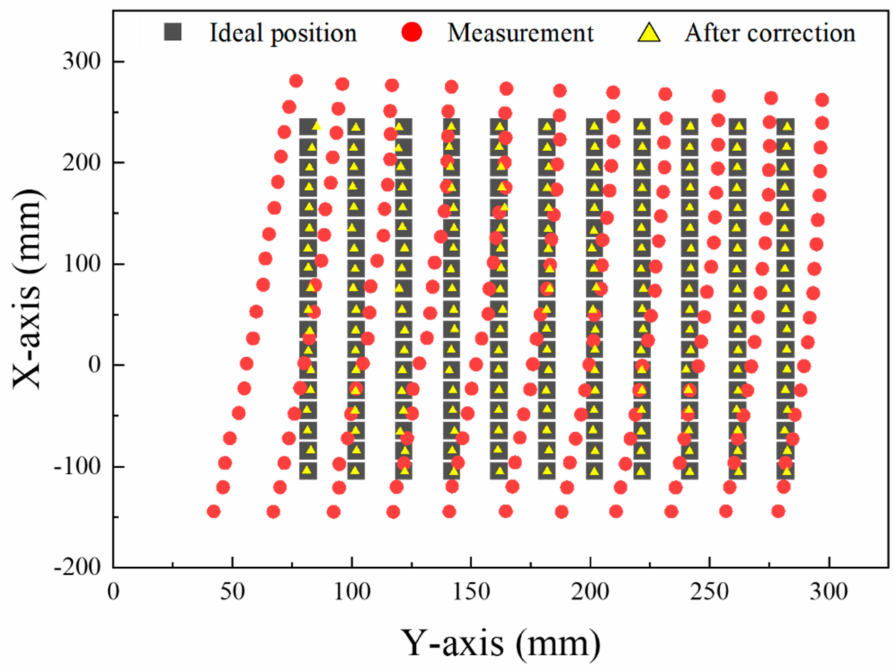
Figure 16. Position differences of the robot before and after compensation using the non-linear correction algorithm for robot